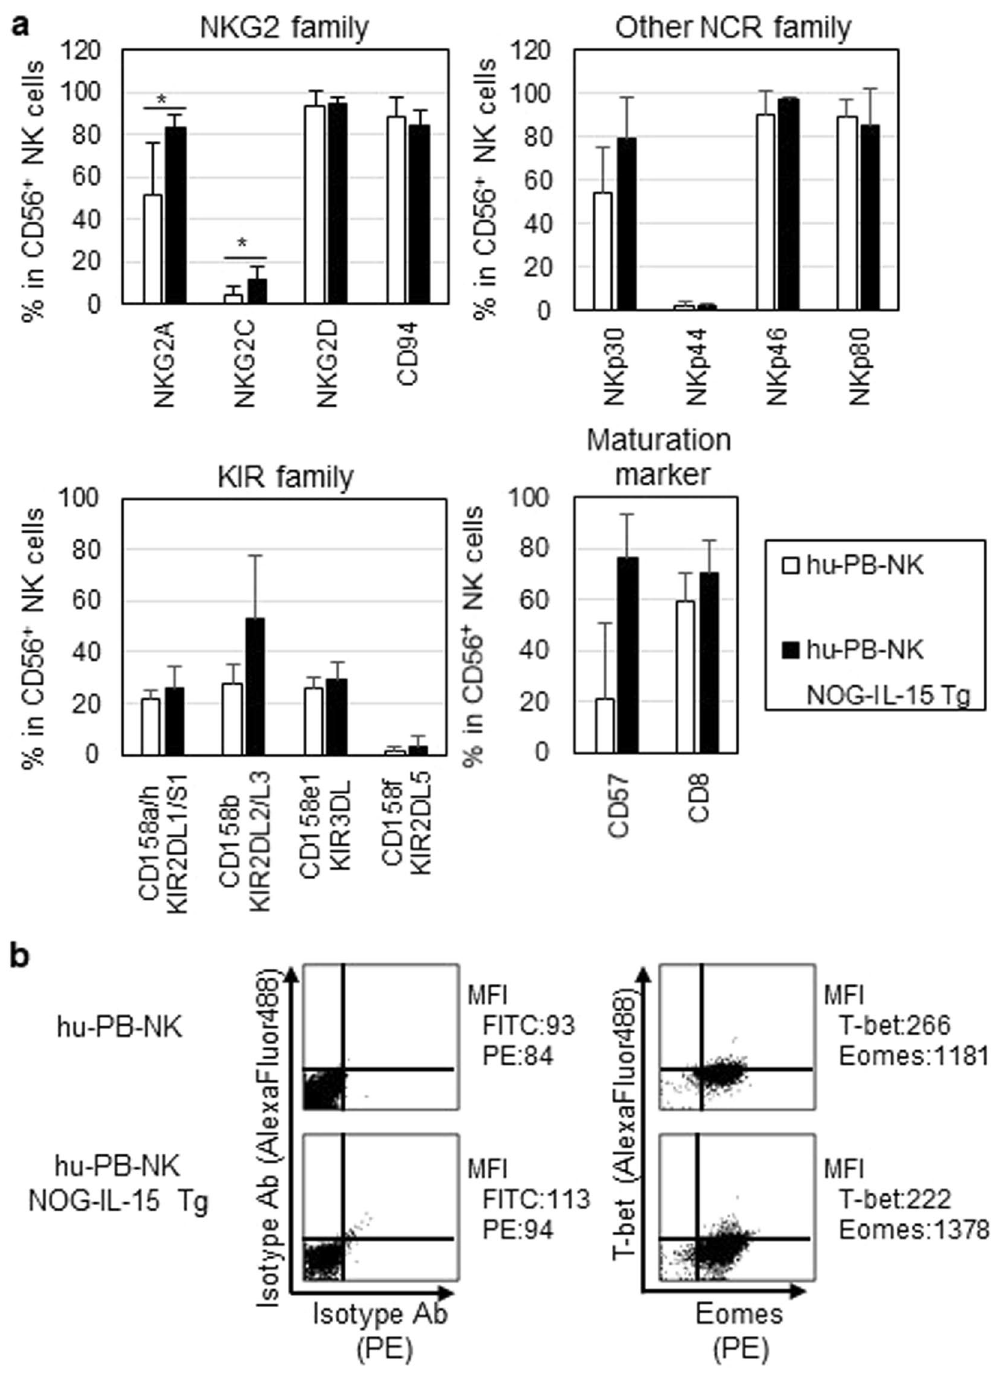
Figure 4. Expression of NK-cell related antigens. ( a ) Expression of NK receptors in hu-PB-NK cells in NOG-IL-15 Tg mice. Freshly isolated hu-PB-NK cells or in vivo -expanded NK cells in NOG-IL-15 Tg mice at 6 to 8 weeks after transfer were used for analyses of NK cell receptors, NKG family molecules, natural cytotoxicity receptors (NCRs), and killer cell immunoglobulin-like receptor (KIR) molecules. Expression of CD57 and CD8, maturation markers for NK cells, was also examined. The means ± SD of each fraction are shown (n = 4). Student’s t -test was performed to assess statistical significance ( * p < 0.05). ( b ) Expression of T-bet and Eomesodermin (Eomes) in human NK cells. The fresh PB-NK cells and in vivo -expanded NK cells in NOG-IL-15 Tg mice were derived from different donors. A representative result is